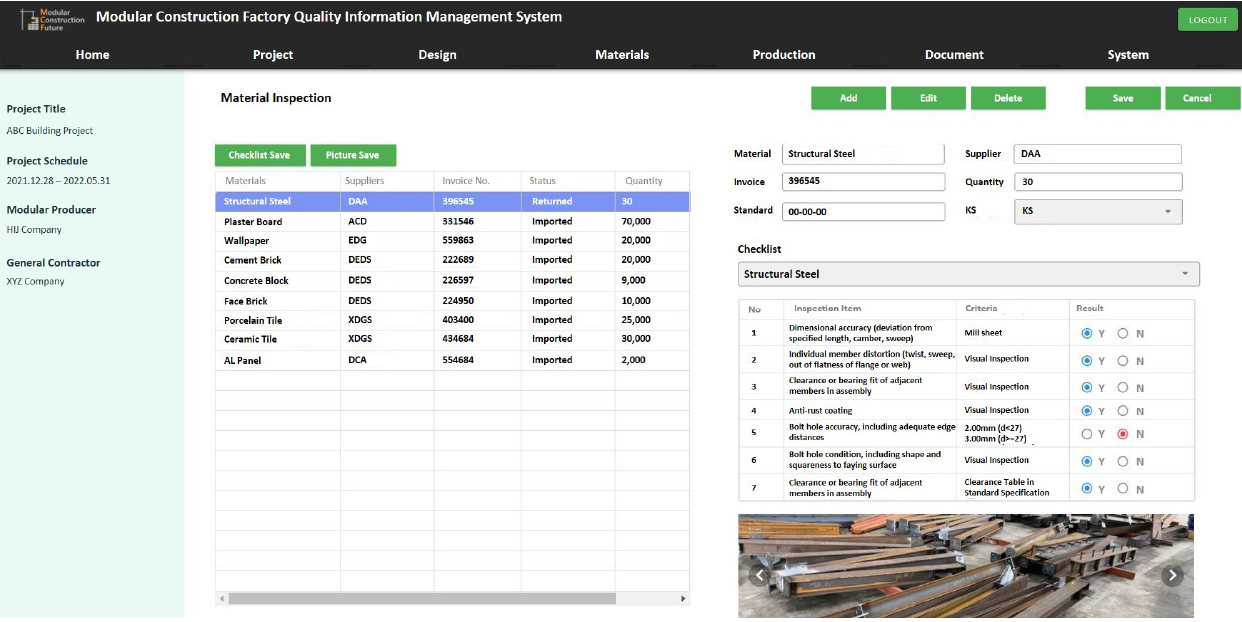
Figure 7. Material inspection information management function.